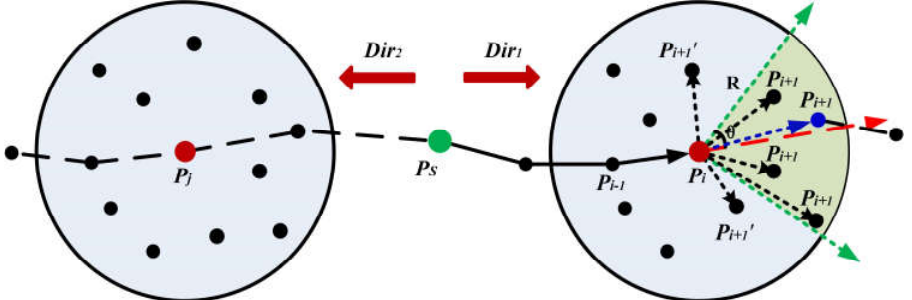
Figure 15. Diagram of the algorithm for establishing a two-way connection for a local vector buffer. The green point is any starting point, the red points are the current search points, the black points are the search points in the neighborhood, the blue point is the next connection point, the red line is the trend of the current trace, the angle θ between the two green lines is the direction threshold, and the search radius is R .